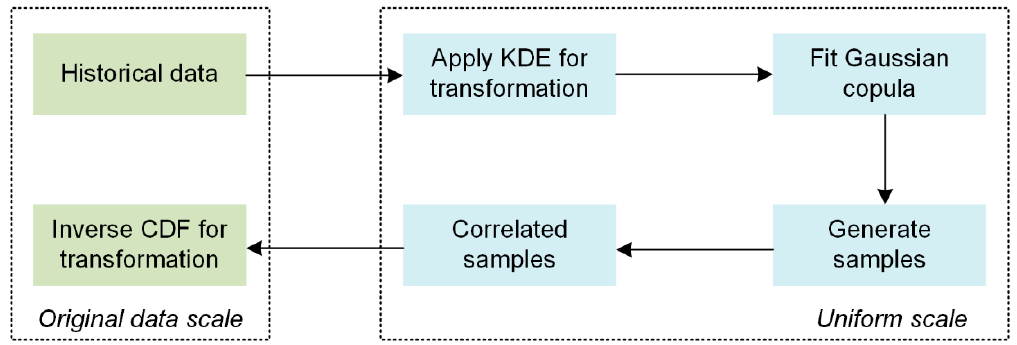
Figure 3. Generating day-ahead loading scenarios using copula.